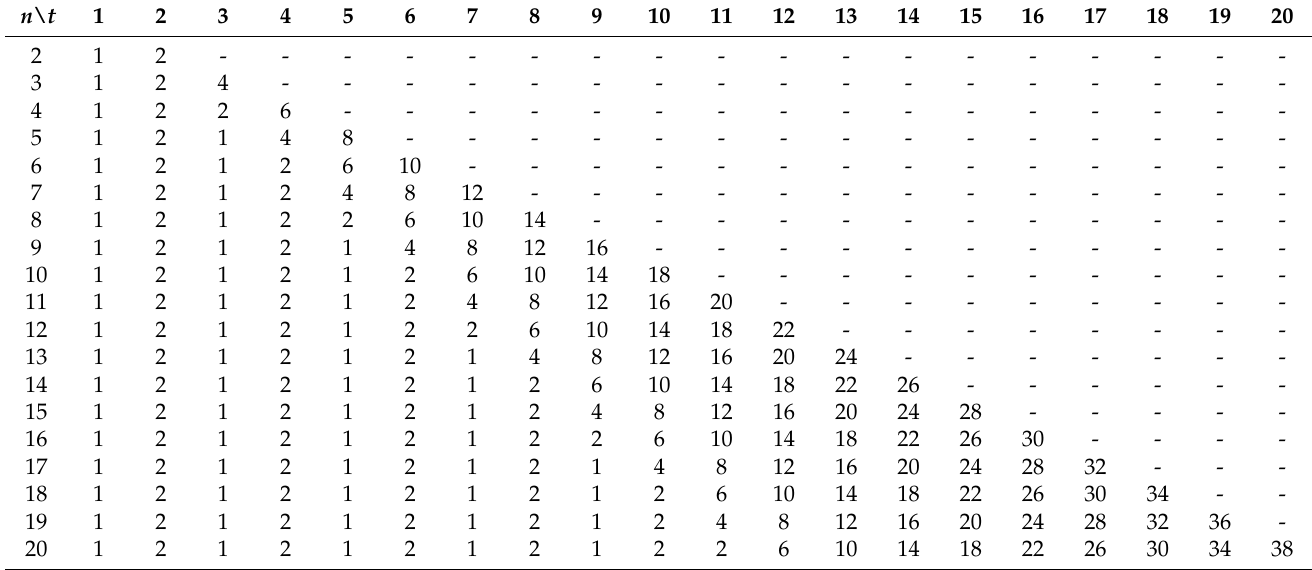
Table 2. Number of connected components of the t -graphs on Z n × Z 2 .